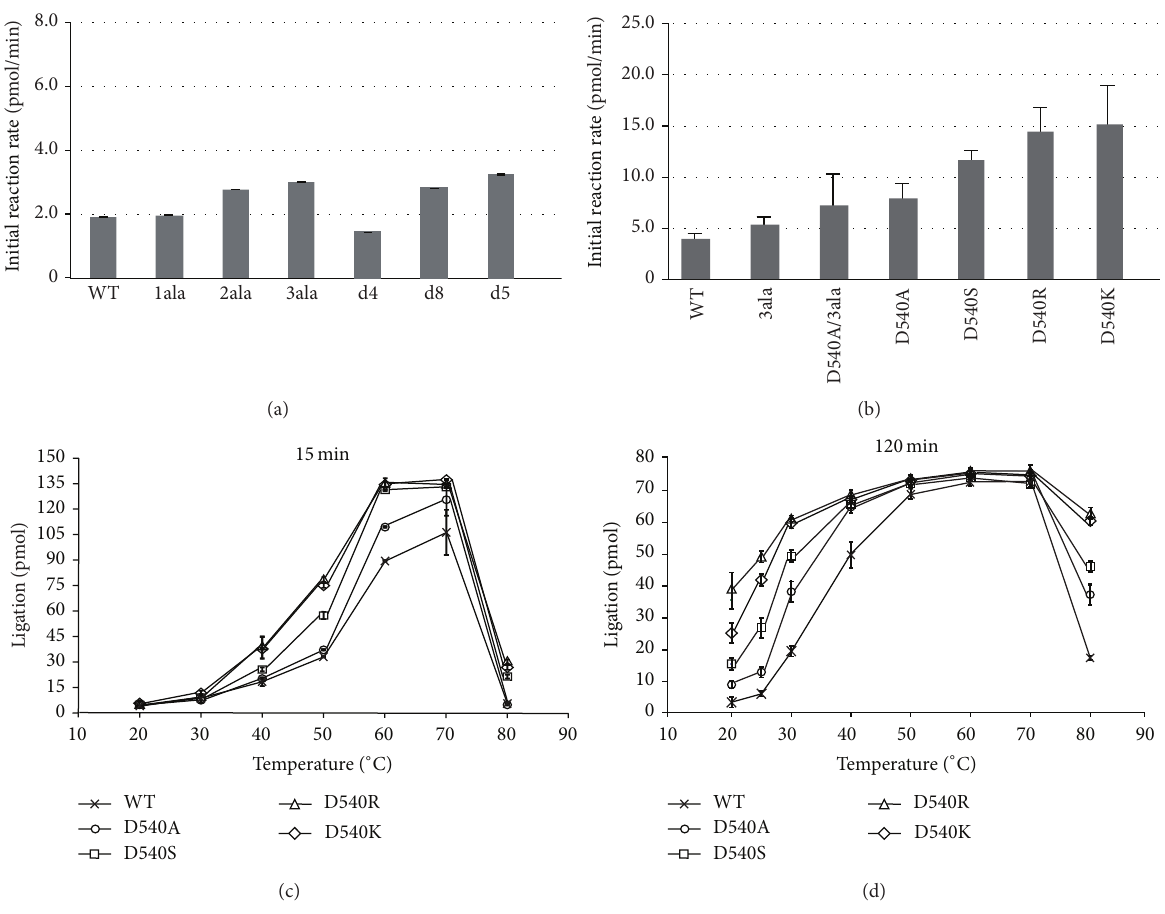
Figure 14: Nick-joining activities of the wild type and mutant proteins. (a) Initial reaction rates for the wild type (WT), K558A (1ala), K554A/K558A (2ala), Q547A/K554A/K558A (3ala), C-terminal 4 residue-deleted mutant d4 (open circles), d8 (open squares), and d15 (open triangles) enzymes, represented by time course data. (b) Initial reaction rates for WT, 3ala, D540A/3ala, D540A, D540S, D540R, and D540K. (c) Nick-joining activities of Asp540 mutants at each temperature for 15min. The extents of nick ligation by D540A (open circles), D540S (open squares), D540R (open triangles), and D540K (open diamonds) were plotted as a function of time. (d) Nick-joining activities of Asp540 mutants at each temperature for 120min. Error bars represent the standard deviation ( 𝑛 = 3 )